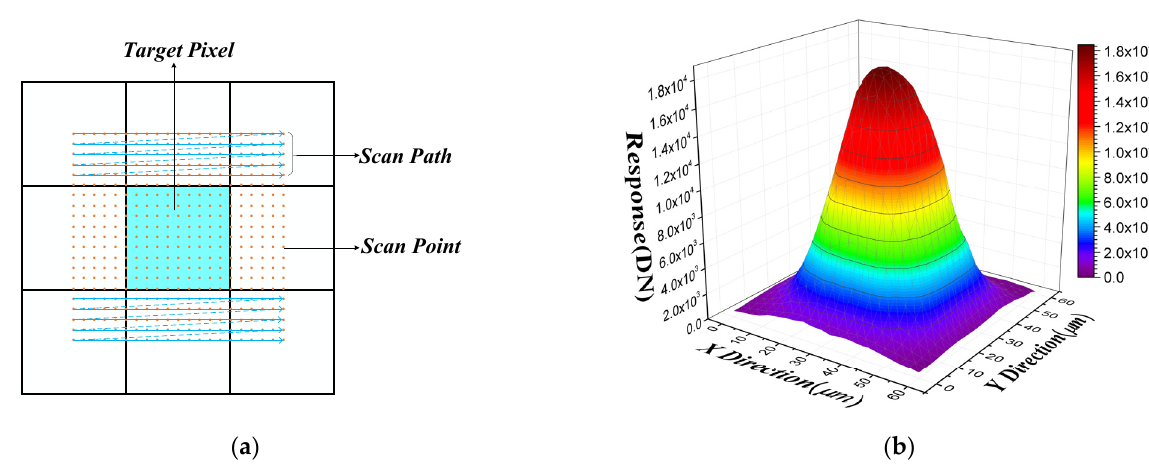
Figure 2. Diagram of the beam spot scan procedure and result: ( a ) schematic diagram of scan procedure; ( b ) beam spot scanning map of infrared FPA photodetector.